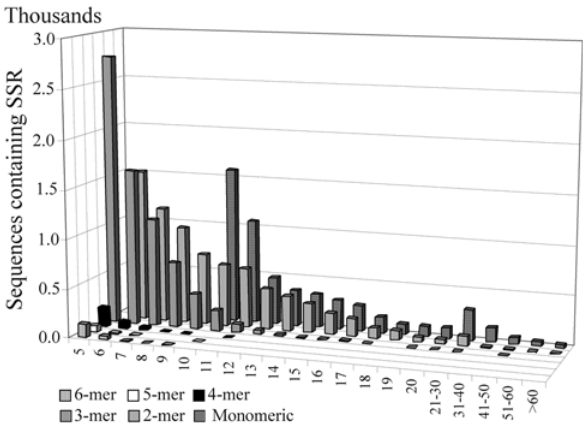
Figure2 -DistributionofthenumberofrepeatsacrosstheSSRmotifcate- gories detected in the 20,530 microsatellites found in the Eucalyptus EST FORESTs